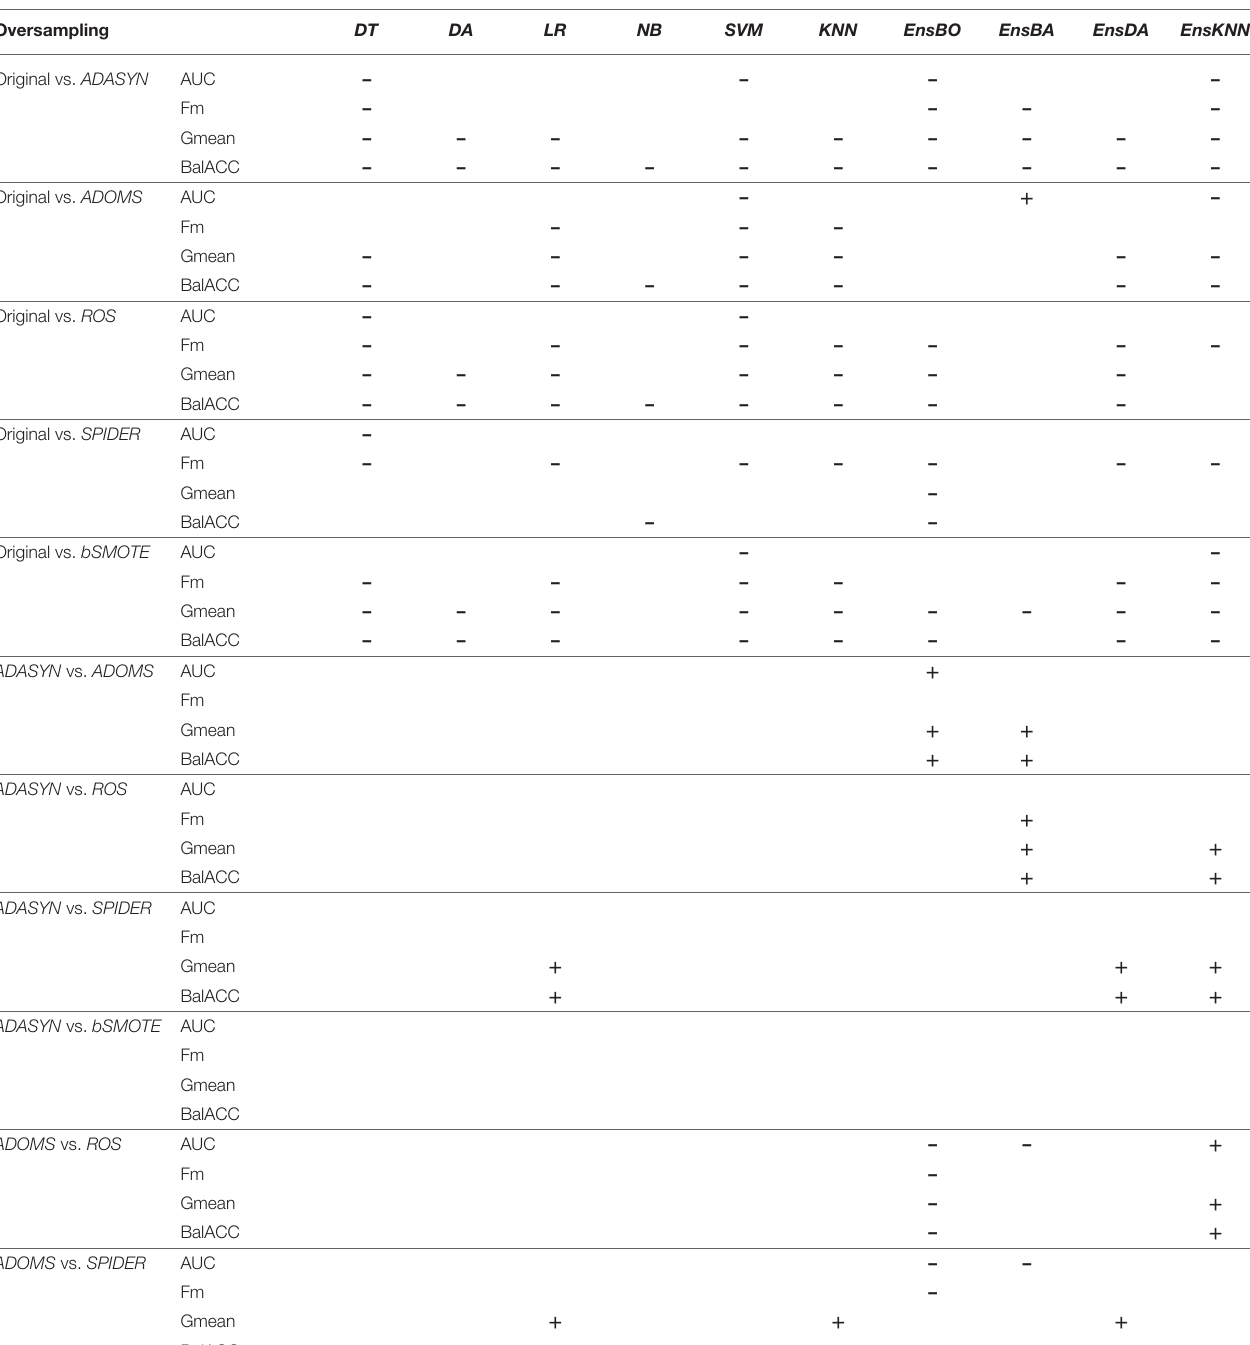
TABLE 3 | Friedman’s and post-hoc Shaffer’s test for the oversampling techniques applied to the four performance measures: Area under the ROC Curve (AUC), F-measure (Fm), Geometric Mean (Gmean), and Balanced Accuracy (BalACC). Oversampling Original vs. ADASYN